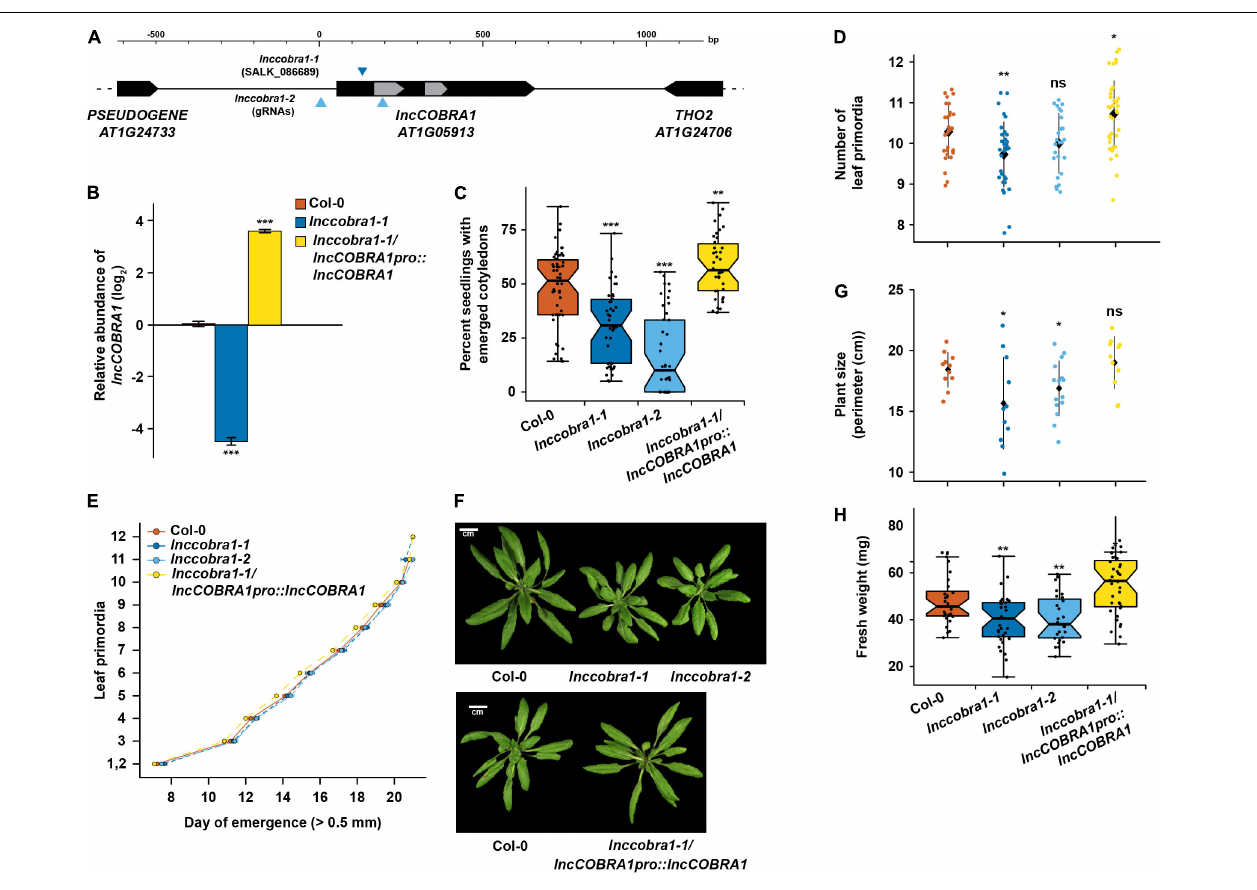
FIGURE 3 | Loss of lncCOBRA1 results in delayed germination and smaller plants. (A) Diagram of lncCOBRA1 ( AT1G05913 ) locus. Gray arrows represent the two snoRNAs annotated within lncCOBRA1 . Triangles represent the location of the T-DNA insertion in SALK_086689 and location of the two guide RNAs used to generate a CRISPR deletion. (B) Relative abundance of lncCOBRA1 in Col-0, lnccobra1-1, and lnccobra1-1/lncCOBRA1pro:lncCOBRA1 . Abundance is normalized by the geomean of UBC9 and UBC10 and relative to Col-0. *** Denotes p -value < 0.001; Wilcoxon t -test. N = 3. Error bars represent SEM. (C) Percent of seeds germinated 48 h after sowing. Over 600 seedlings were measured per genotype on over 37 independent plates. *** Denotes p -value < 0.001; Wilcoxon t -test. (D) Number of leaf primordia > 0.5 mm in 3-week-old plants. N > 27 plants per genotype. ns, *, and ** denotes p -value > 0.05, < 0.05, and < 0.01, respectively; Wilcoxon t -test. Black diamond represents the mean ± SD. (E) Leaf initiation rate. The date was recorded for the first day each leaf primordia was visible by eye, ∼ 0.5 mm. N > 27 plants per genotype. Error bars represent SEM. (F) Representative images of 5-week-old Col-0, lnccobra1-1 , lnccobra1-2 , and lnccobra1-1/lncCOBRA1pro:lncCOBRA1 . Plants were grown in a 16/8 h light/dark photoperiod at 22 ◦ C. All photos were taken the same day. (G) Plant perimeter analysis using ImageJ (see section “Materials and Methods”). N > 11 per genotype. * Denotes p -value < 0.05; Wilcoxon t -test. Black diamond represents the mean ± SD. (H) Fresh weight of aerial tissue from 3-week-old plants. N > 27 plants per genotype. * and ** denote p -value < 0.05 and < 0.01, respectively; Wilcoxon t